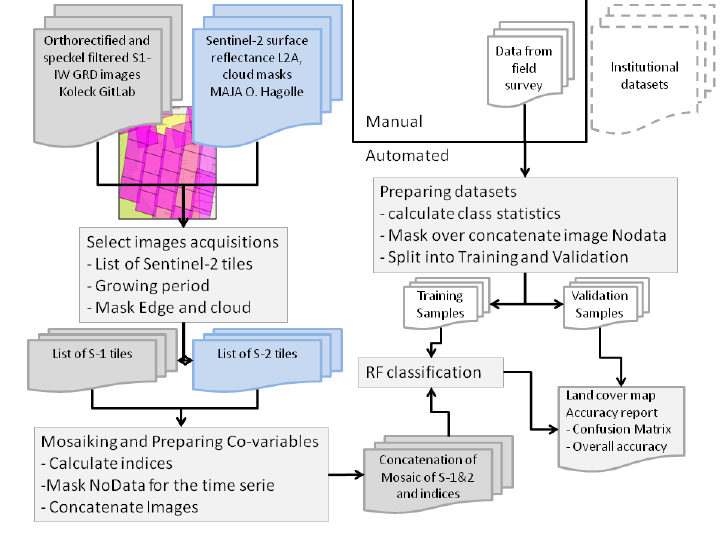
Figure 2. Automatic seasonal land cover